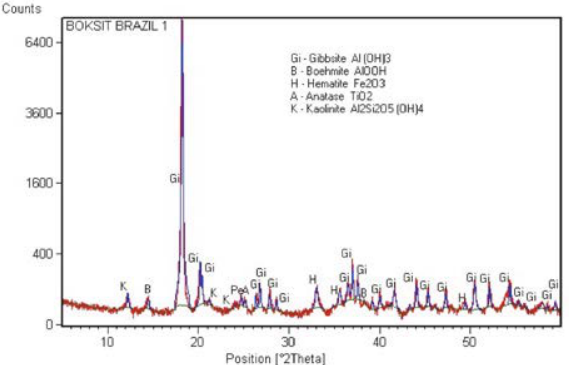
tite, anatase, and kaolinite, all in traces (Figure 6).